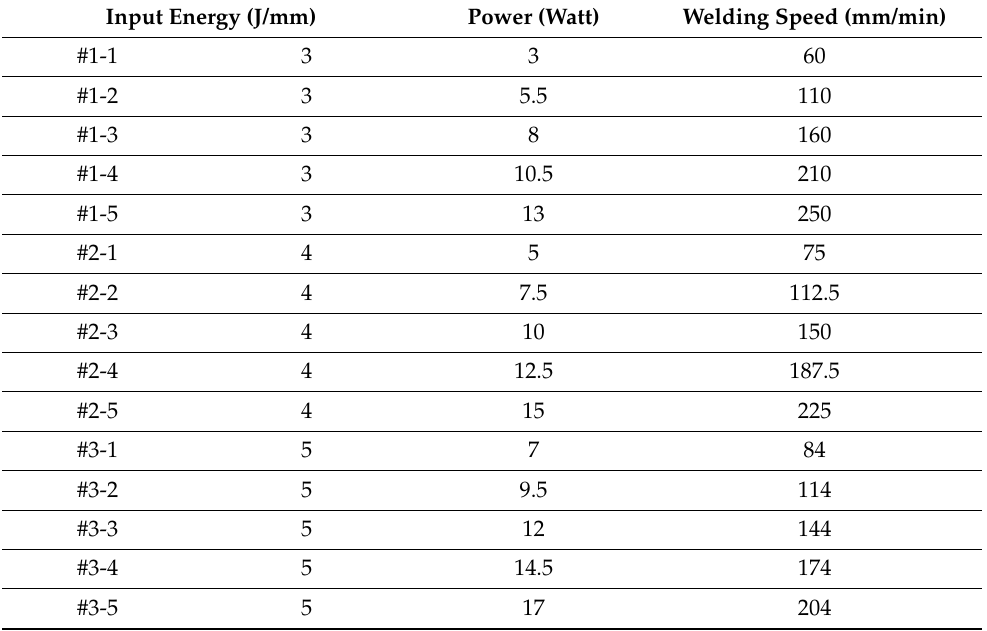
Table 1. Matrix of welding schedule.